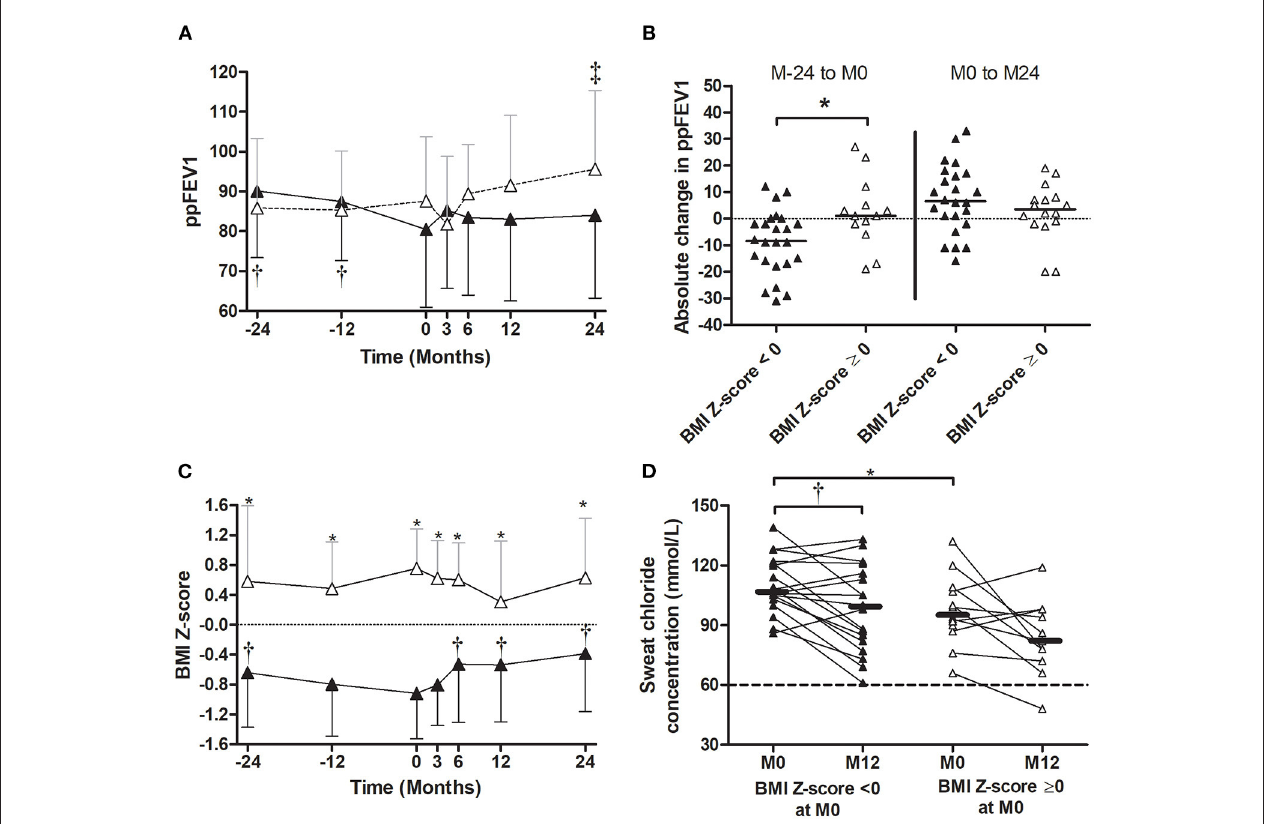
FIGURE 5 | Evolution of the percent predicted forced expiratory volume in 1s (ppFEV1), body mass index (BMI) Z -score, and sweat chloride before and after the initiation of lumacaftor/ivacaftor (LUM/IVA) in patient with or without BMI Z -score < 0. Evolution of ppFEV1 (A) and BMI Z -score (C) 2 years prior (M-24) to 2 years after (M24) LUM/IVA initiation (M0) in patient with (black triangle) or without (empty triangle) BMI Z -score < 0. Absolute changes of ppFEV1 between M-24 to M0 [ (B) left] and M0 to M24 [ (B) right]. Evolution of sweat chloride from M0 to M12 in patients with or without BMI Z -score < 0 (D). Comparisons with data obtained at M0 were performed using the Wilcoxon paired test (A,B,D) and between the two groups using the Mann–Whitney test. *, † , and ‡ Indicate significant difference ( p < 0.05) compared with M0 in patients with ppFEV1 < 80% ( † ) and in patients with ppFEV1 ≥ 80% ( ‡ ) or between groups